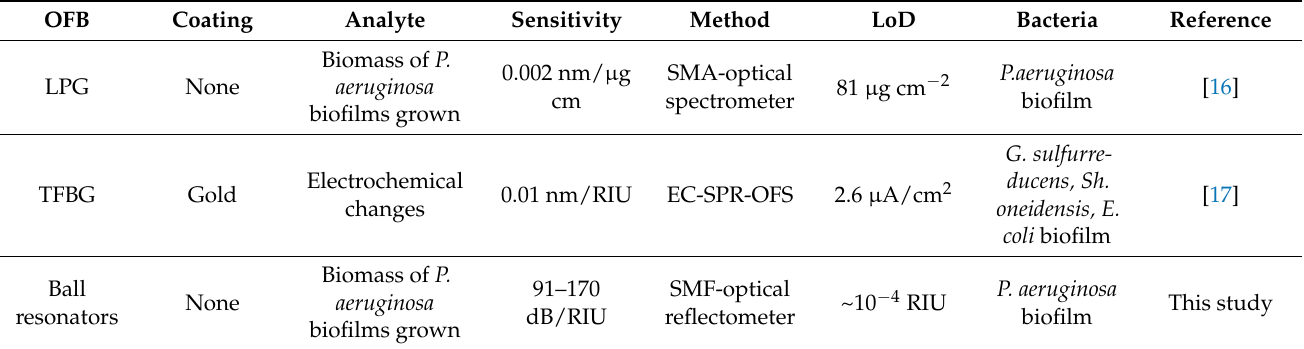
Table 1. Main results obtained with optical fiber biosensors in monitoring biofilm formation; the table shows the OFB methods, types of biofilm, sensitivity, limit of detection (LoD), and technology readiness level